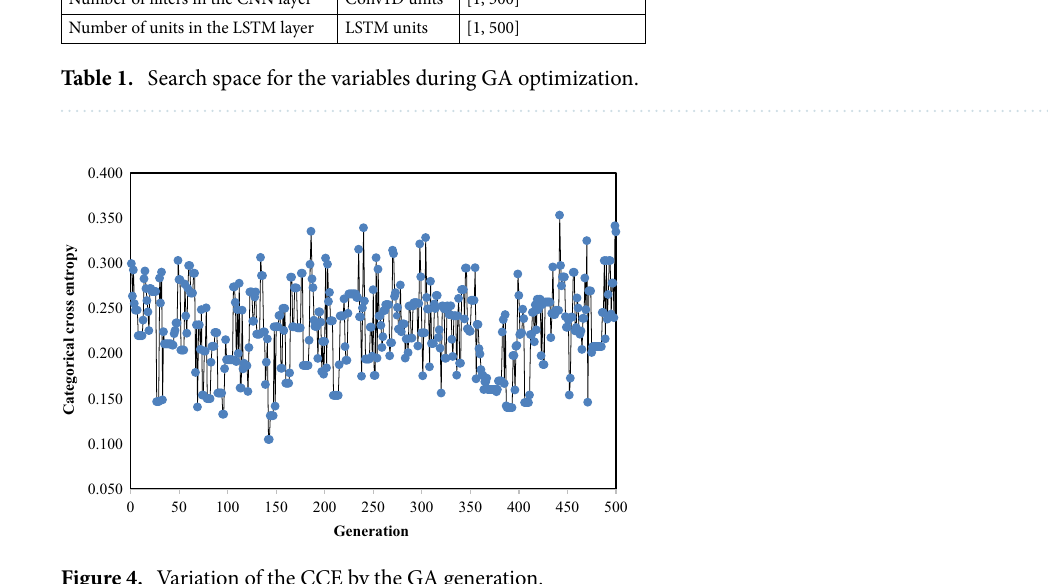
Figure 4. Variation of the CCE by the GA